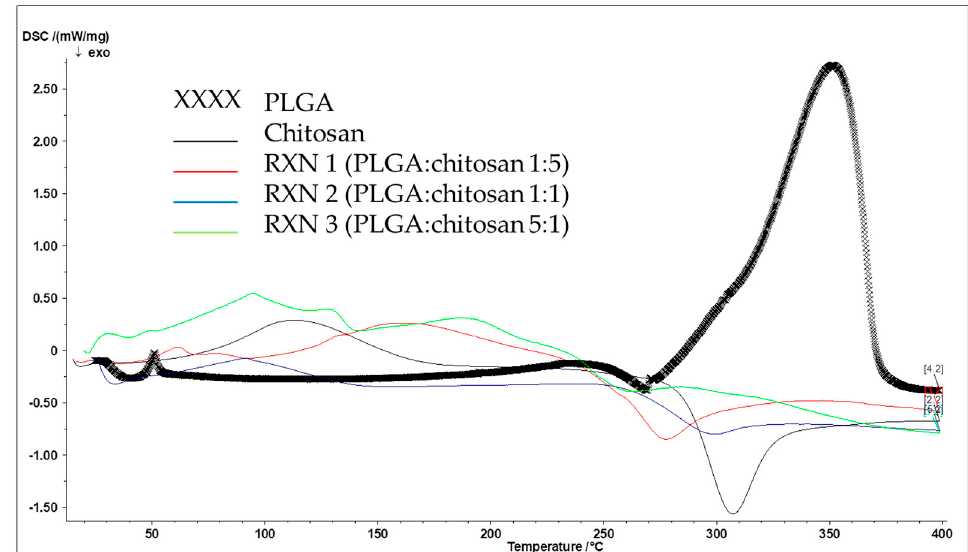
Figure 5. Dynamic scanning calorimetry analysi: PLGA ( black crosses ), chitosan ( black line ), and the three PLGA-chitosan reaction products based on PLGA:chitosan molar rapport: 1) 1:5 ( red ) 2) 1:1 ( blue ) and 3) 5:1 ( green ).